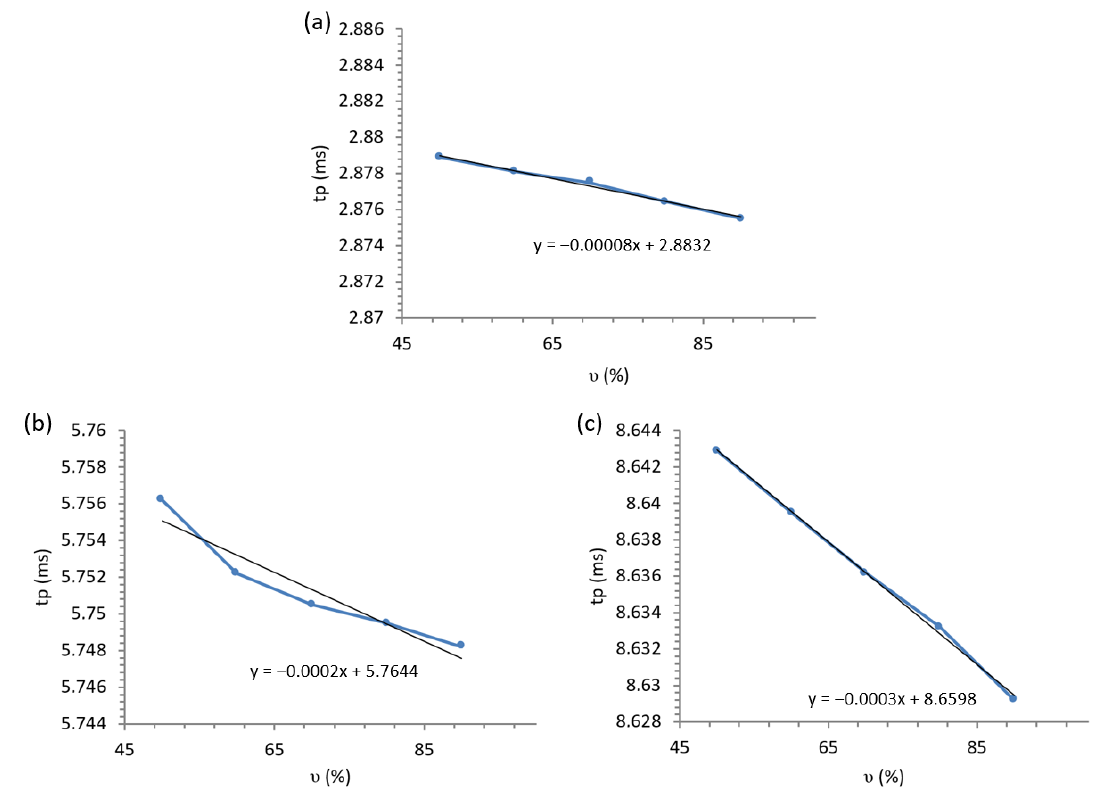
Figure 14. Graph showing the dependence of wave propagation time on air relative humidity at a distance of: ( a ) 1 m, ( b ) 2 m, ( c ) 3 m.